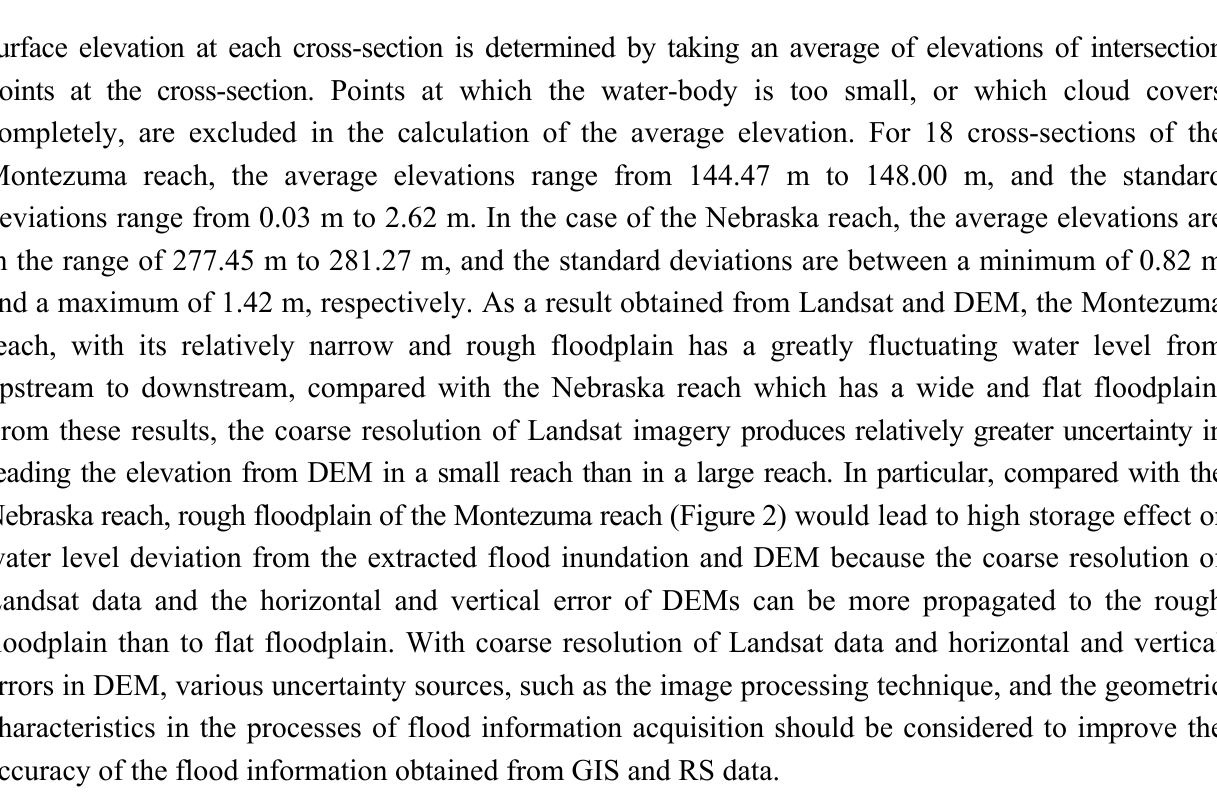
Figure 5. The water surface elevation (WSE) obtained from Landsat image and water surface elevation from Monte Carlo (MC) simulations. ( a ) For the Montezuma reach; ( b ) For the Nebraska